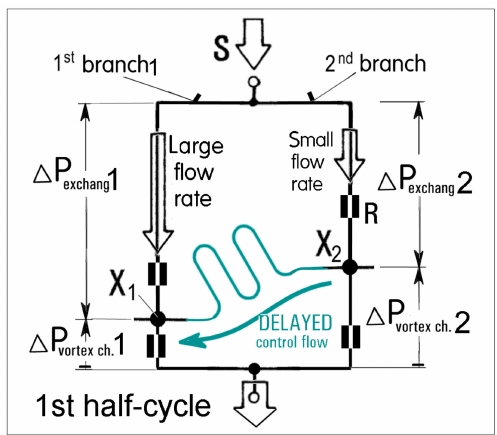
Figure 28. Explanation of generated delayed fluid flow generating rotation in the vortex chamber 1 . For simplicity of explanation the exchanges as well as vortex chambers are replaced by fluidic resistors R.